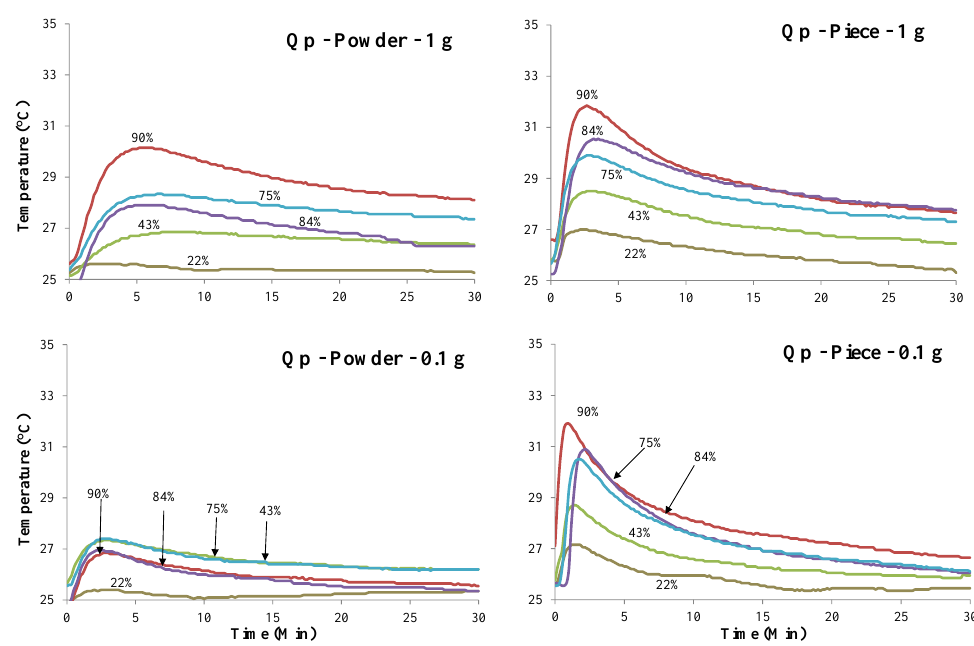
Figure 2 . Temperatures (°C) measurement vs. time (min) of Bamboo (B) and Quercus pubescens (Qp) biochars for powder and piece and 0.1 and 1 g, respectively, exposed to the five selected air humidity (%) conditions.